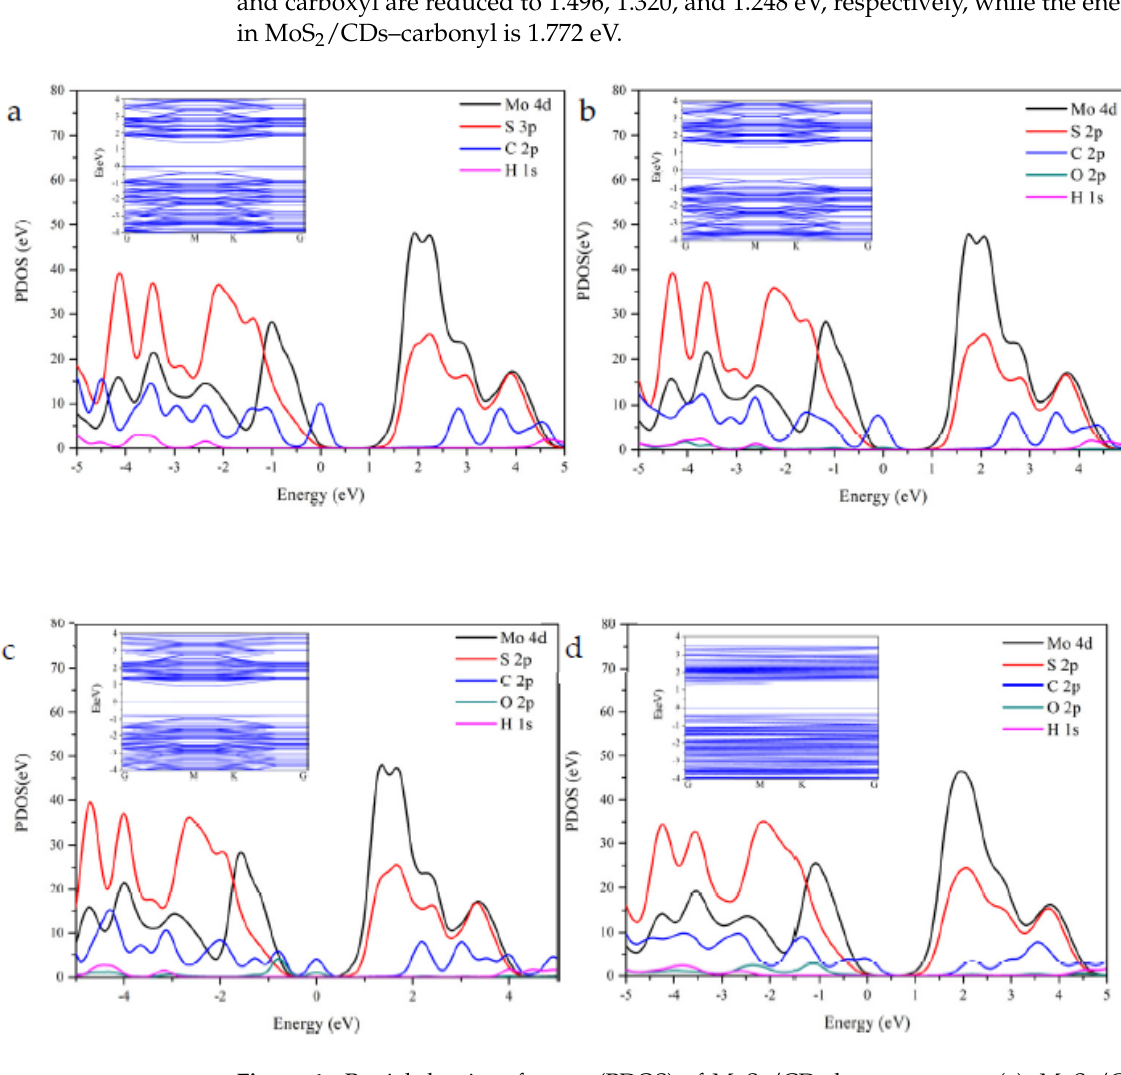
Figure 4. Partial density of states (PDOS) of MoS 2 /CDs heterostructure ( a ), MoS 2 /CDs-T heterostructures (T is hydroxyl ( b ), carbonyl ( c ), and carboxyl ( d )); the insets in these figures are the corresponding band structures.